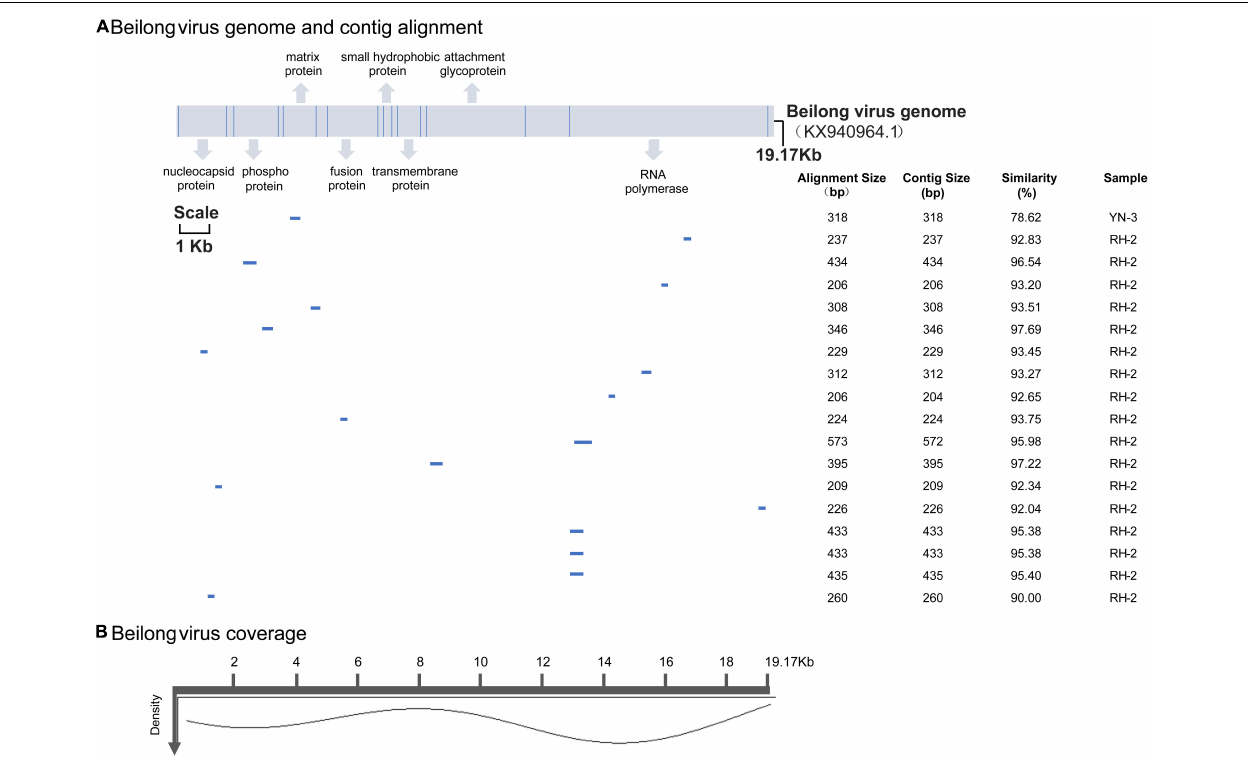
FIGURE 4 | (A) BeiV genome and polyprotein organization. Mature proteins are represented by cylinders. Coordinates are based on the reference (KX940964.1). Labels are as described in Figure 3 . (B) Genome coverage after reference-based assembly using Bowtie v2 for one representative